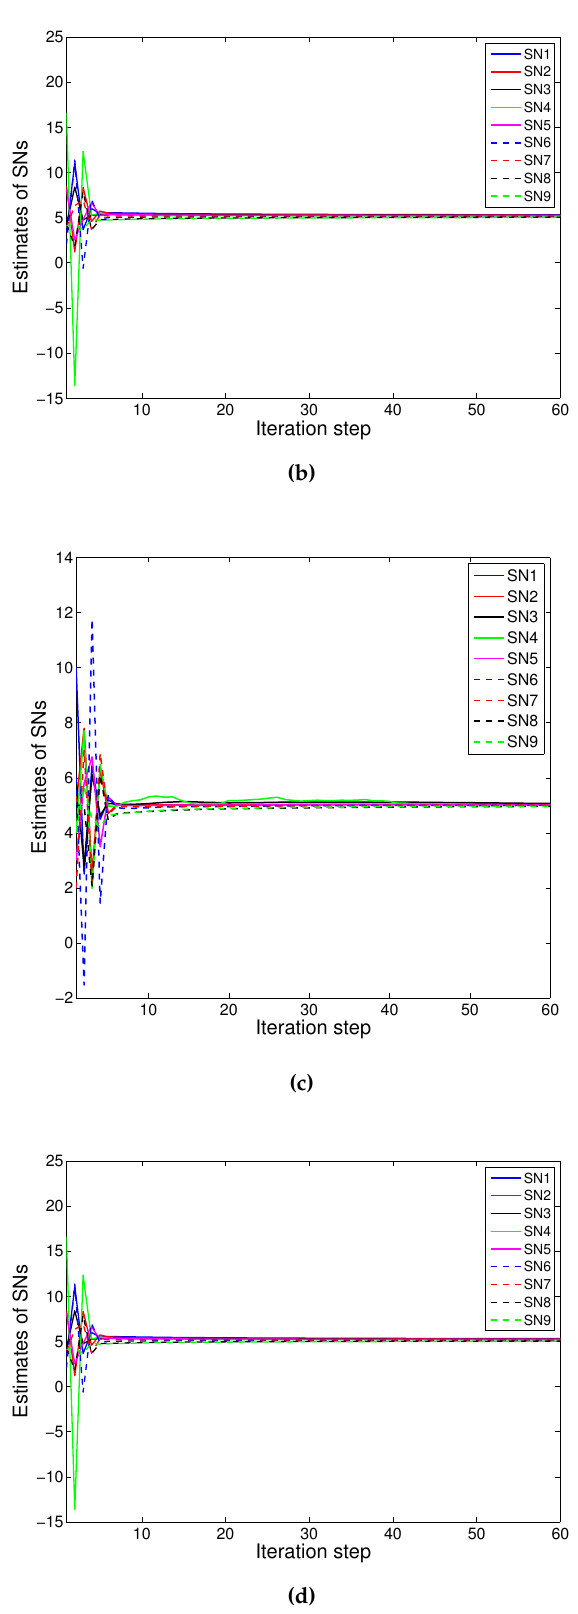
Figure 2. Convergence of parameter adjusted-based consensus (PACS): ( a ) without attackers; ( b ) with one Perception Data Falsification (PDF) attacker; ( c ) with one Iteration Data Falsification (IDF) attacker; ( d ) with one Random Data Falsification (RDF)